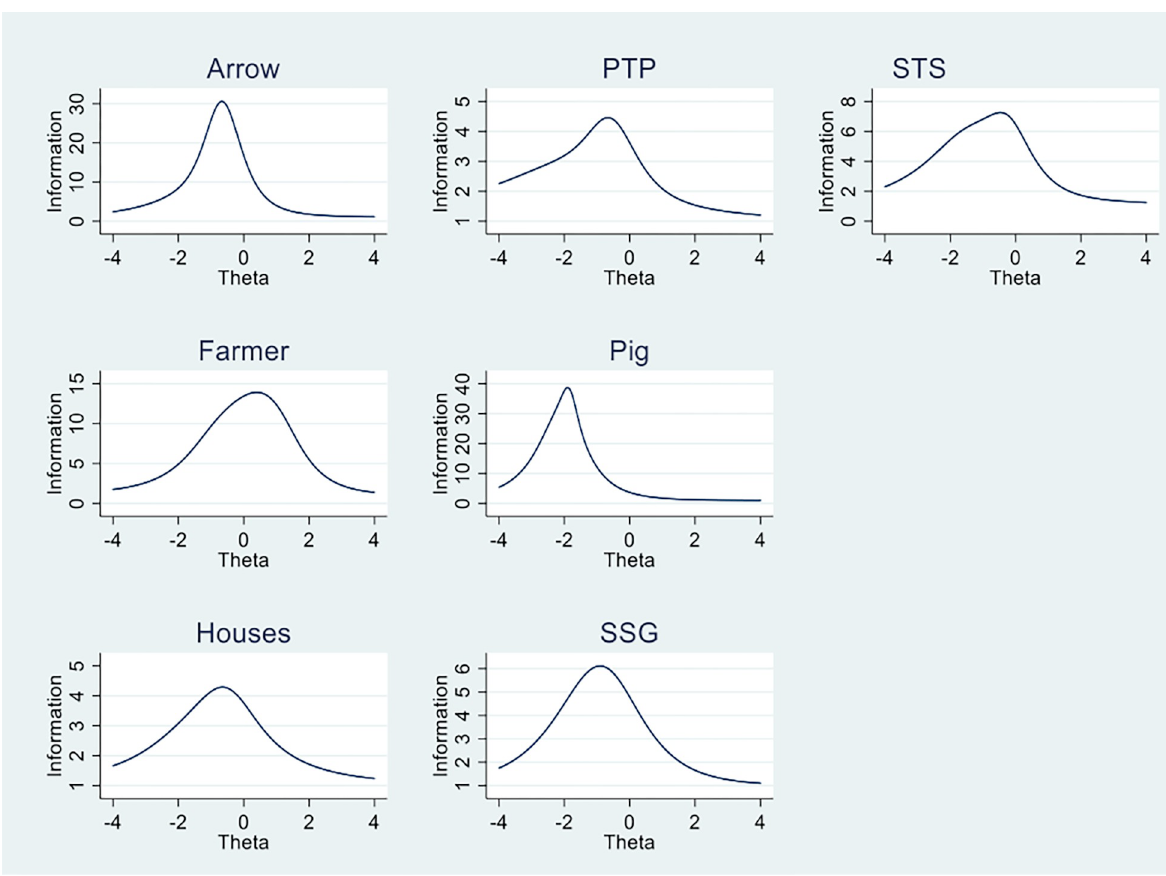
Fig 2. Test information curves of arrow, Silly Sound game (SSG), Houses, Something’s the same (STS), Pig, Pick the picture (PTP), and farmer task +-4 SD around the mean level of executive function ability.